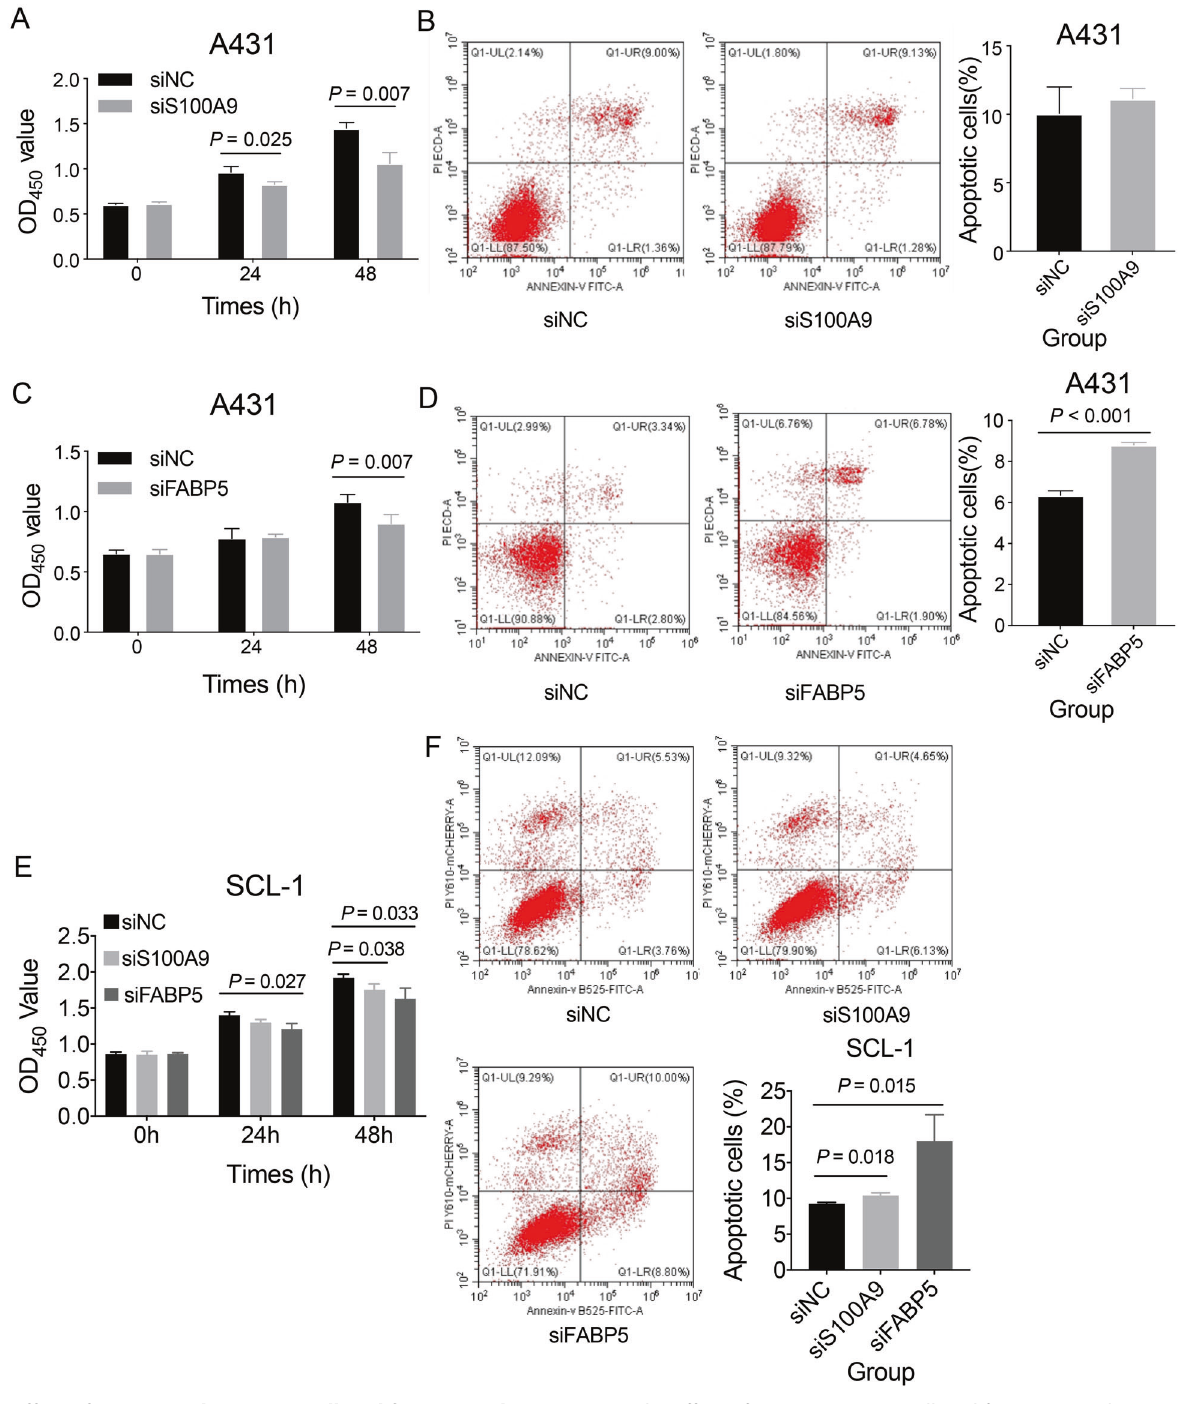
Fig. 6 Effect of S100A9 and FABP5 on cell proliferation and apoptosis. A The effect of S100A9 on A431 cell proliferation was determined by CCK-8. B The effect of S100A9 on A431 cell apoptosis was measured by staining with Annexin V/PI, followed by FACS analysis. C The effect of FABP5 on A431 cell proliferation was determined by CCK-8. D The effect of FABP5 on A431 cell apoptosis was measured by staining with Annexin V/PI, followed by FACS analysis. E The effect of S100A9 and FABP5 on SCL-1 cell proliferation. F The effect of S100A9 and FABP5 on SCL- 1 cell apoptosis. Data were presented as mean ± SD. siNC represents the siRNA negative control, and si S100A9 and si FABP5 represent the speci fi c S100A9 siRNA and FABP5 siRNA,